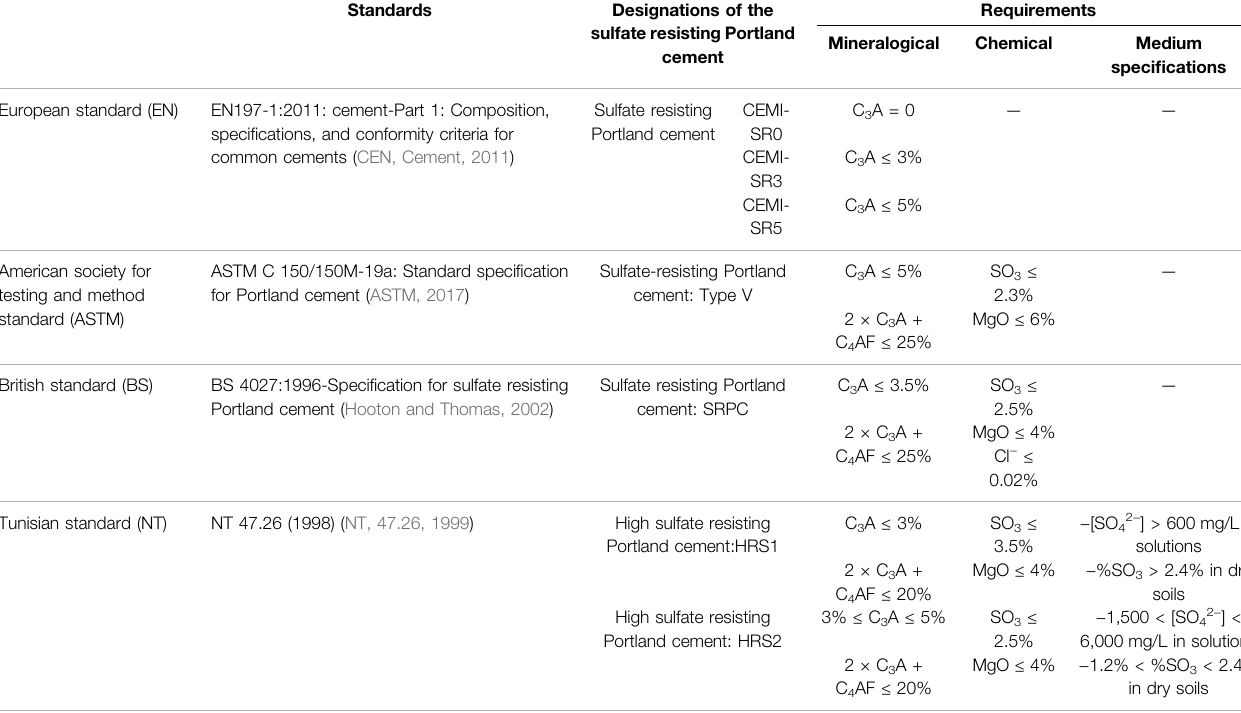
TABLE 1 | Sulfate-resisting Portland cement standards.